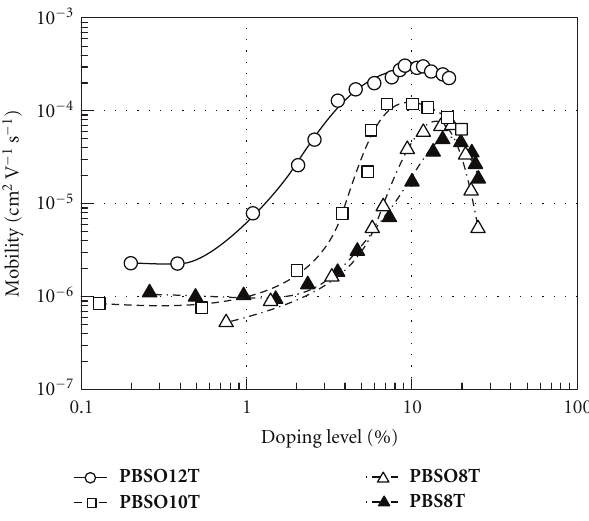
Figure 7: Apparent mobilities of charge carriers plotted against doping level for (cid:2) : PBS8T , Δ : PBSO8T , (cid:3) : PBSO10T , and (cid:4) : PBSO12T